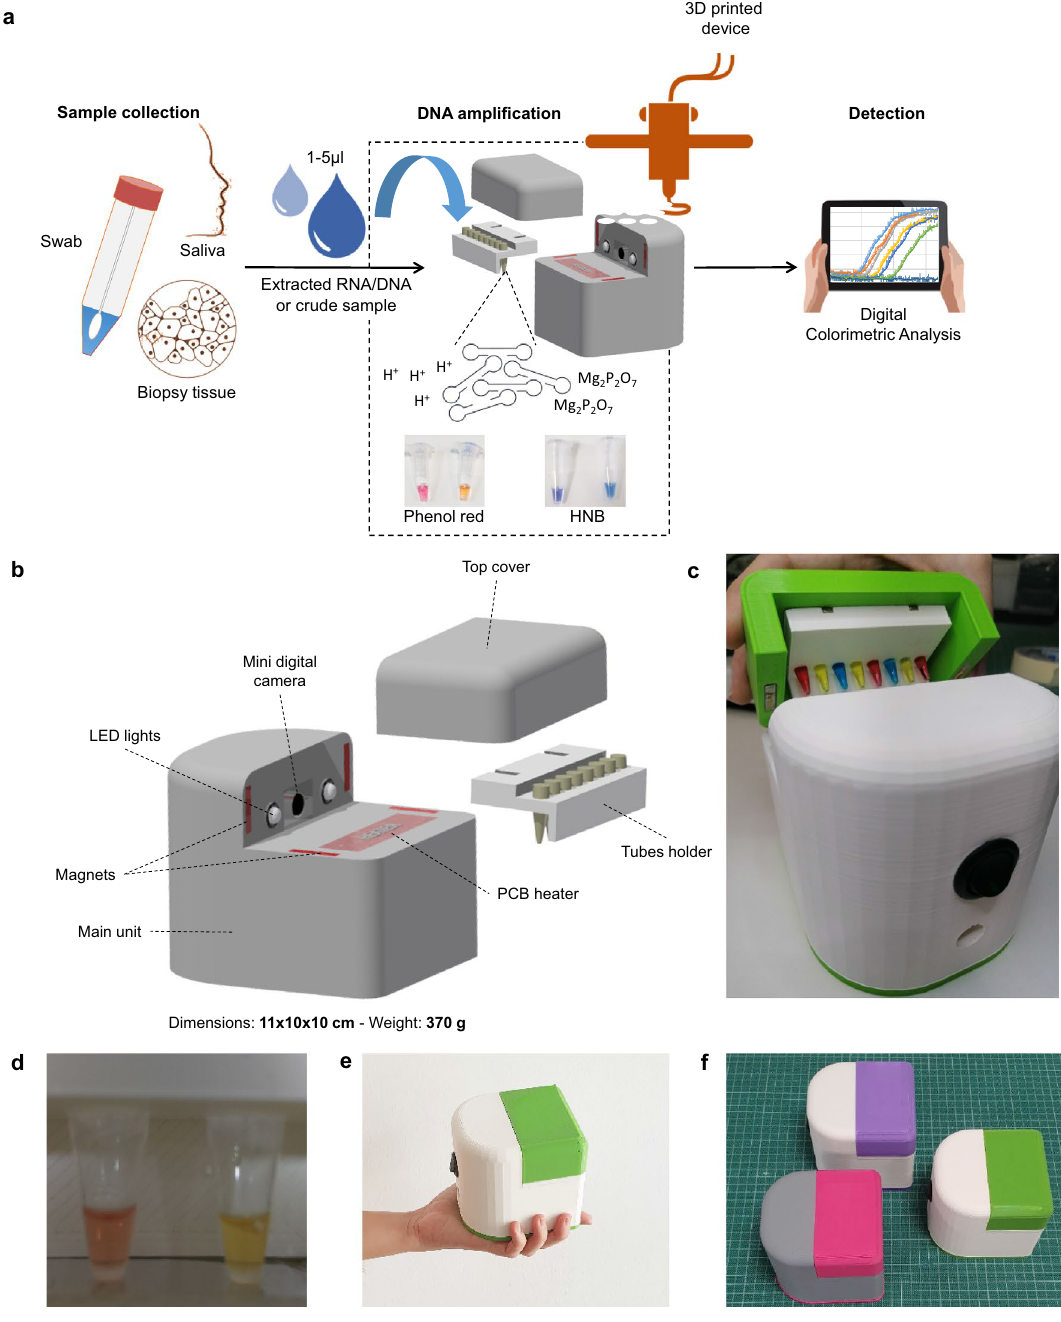
Figure 1. ( a ) Overview of the real-time quantitative colorimetric LAMP (qcLAMP) concept. Bottom: ( b ) Schematic representation of the qcLAMP device and components. ( c ) Photograph of the device and tubes- holder. ( d ) Captured image of two Eppendorf-tubes inside the chamber and during operation of the device. ( e ) Image of the handheld device for performing qcLAMP. ( f ) Three prototype devices of various colors; parallel production of two boxes requires ~ 12